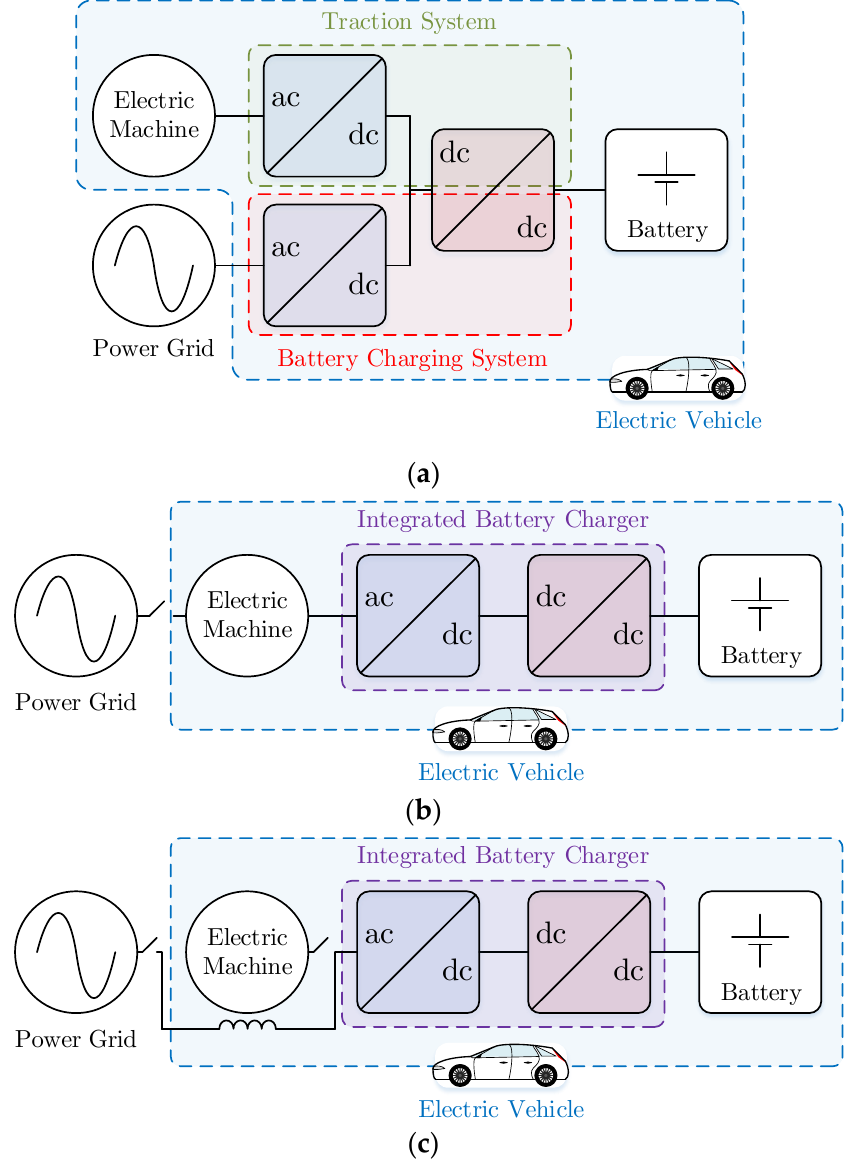
Figure 1. EV power electronics structure: ( a ) conventional; ( b ) integrated using the machine windings as coupling filters with the power grid; ( c ) integrated using external inductors as coupling filters with the power grid.